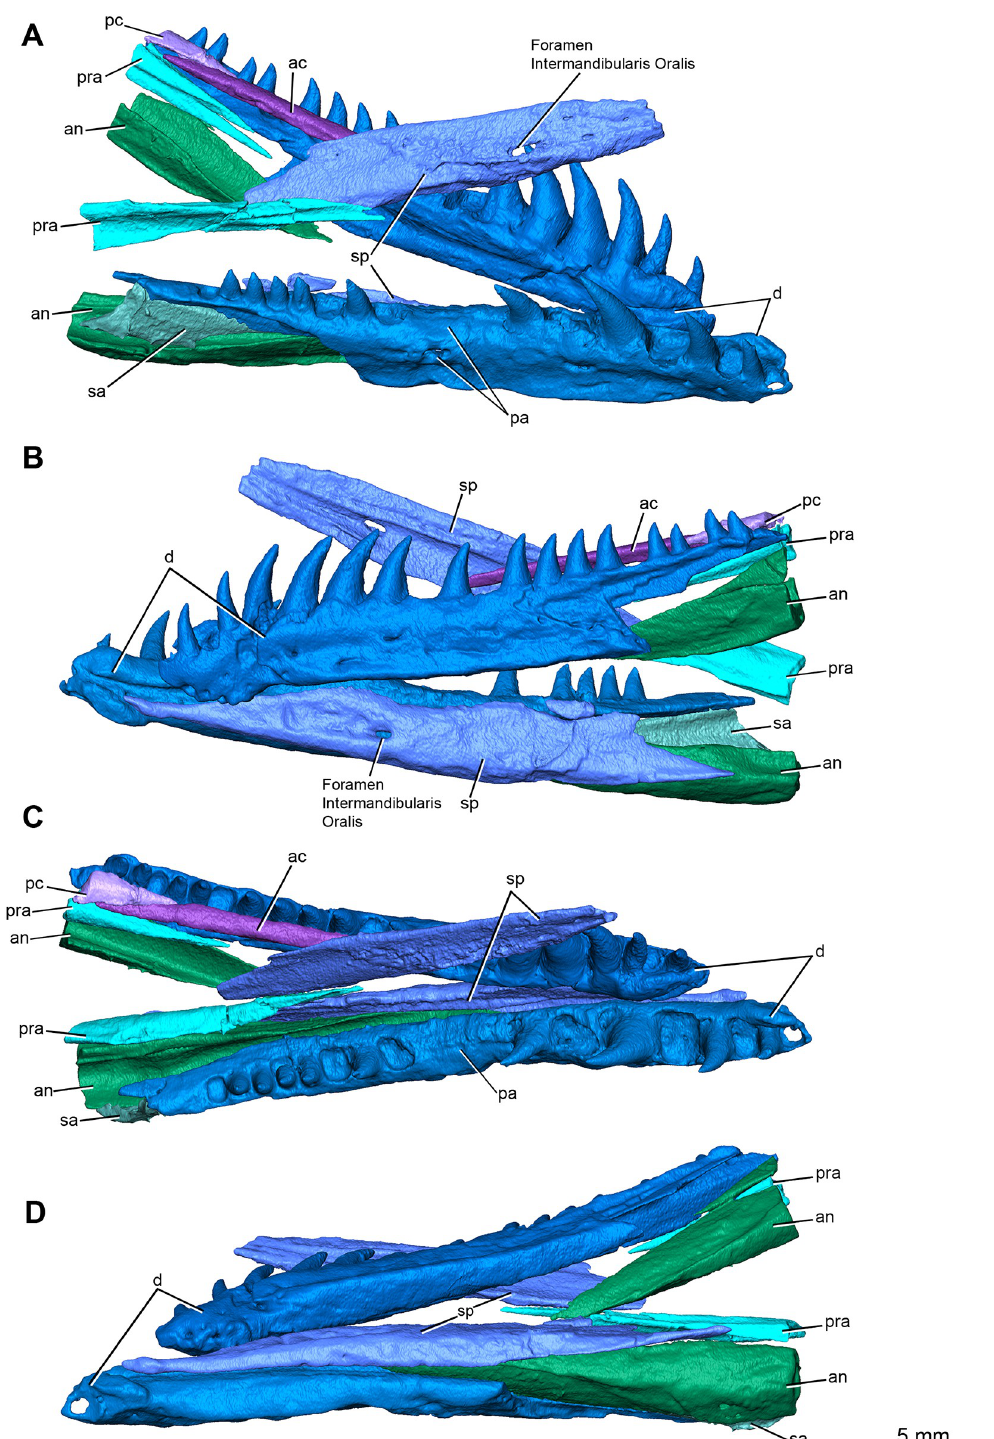
Fig 6. Rendering of Maiothisavros dianeae (ROMVP 87366) mandible from CT imaging sequences. Right and left dentary, right and left angular, right and left splenial, right surangular, anterior coronoid, and posterior left coronoids in (A) right lateral, (B) left lateral, (C) dorsal, and (D) ventral views. Abbreviation: an, angular; ac, anterior coronoid; d, dentary; pa, pathology; pc, posterior coronoid; pra, prearticular; sa, surangular; sp, splenial.